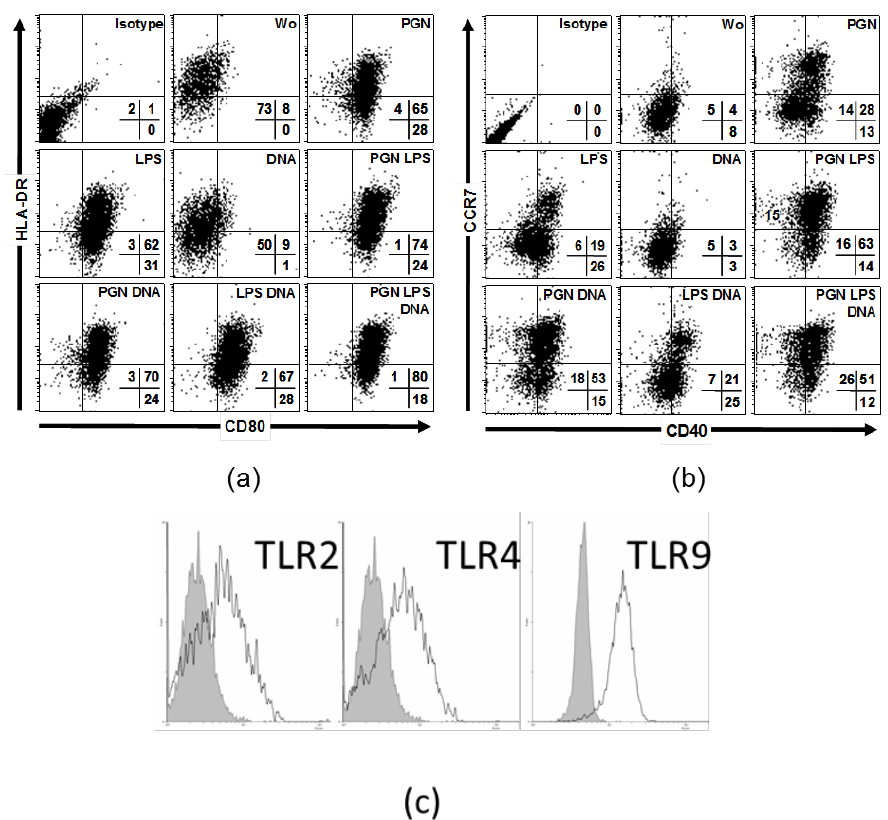
Figure 2. Triple TLR agonist activation increases LC-surface markers. MoLCs were activated by combinatory TLR2, TLR4 and TLR9 agonists: 20 µg/mL PGN, 1 µg/mL LPS, and 5 µg/mL DNA, respectively. ( a ) Dot plots show coexpression of CD80 and HLA-DR after 48 h. ( b ) Dot plots show coexpression of CD40 and CCR7 after 48 h. Quadrants indicate isotype controls, numbers percent positive cells. ( c ) Surface expression of TLR2, TLR4 and TLR9 in MoLCs. FACS staining of cells from one donor represents experiments from five donors with similar results.